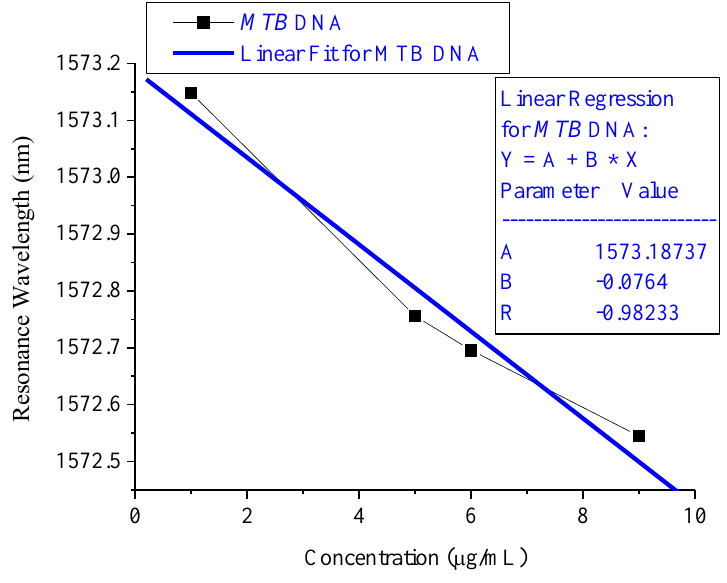
Figure 4. The MTB DNA sensor sensitivity in non-immobilization